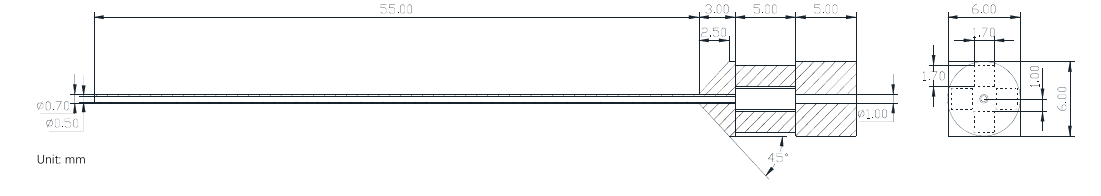
Figure 5. Schematic diagram of the scanner geometry. Table 1. Material parameters of the scanner.